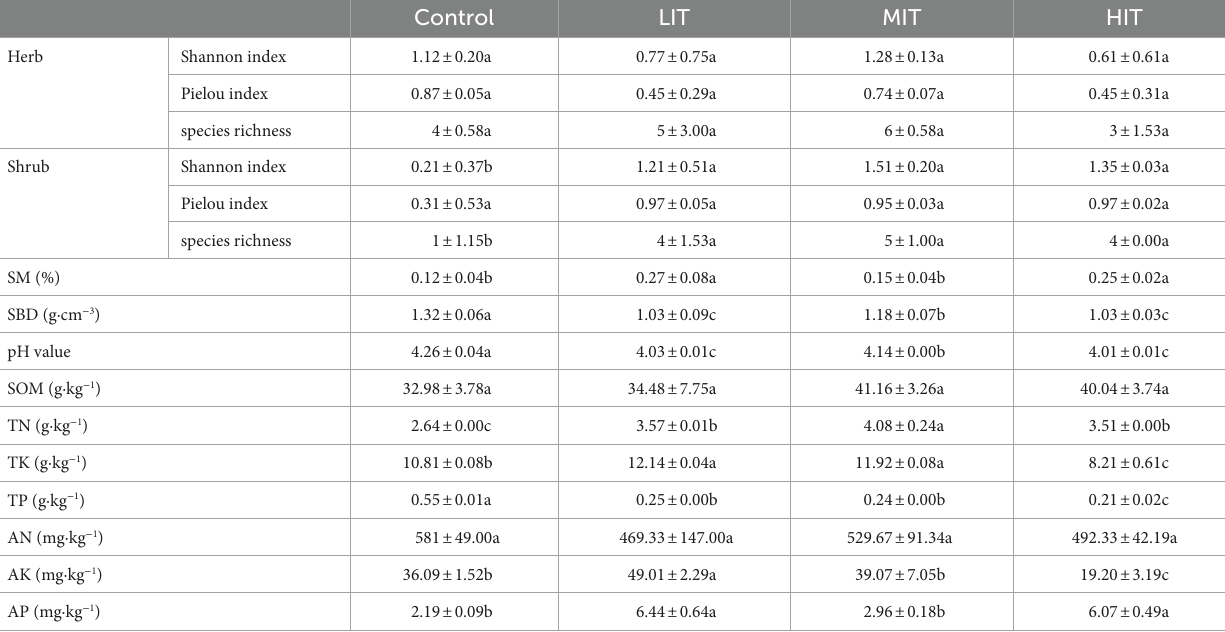
TABLE 2 Understory vegetation and soil properties in Cryptomeria japonica var. sinensis plantations under four thinning treatments.